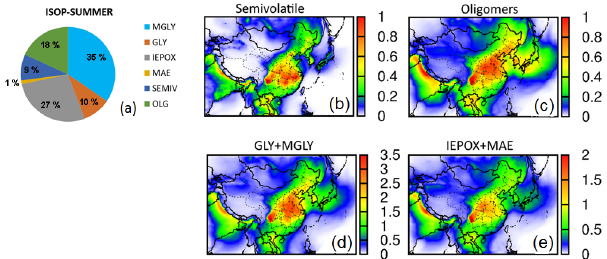
Figure 8. Predicted fractional component contributions to summer isoprene SOA in China (a) and spatial distributions of iSOA from the traditional (b, c) and surface uptake (d, e) pathways. Units are µgm − 3 for panels (b–d)